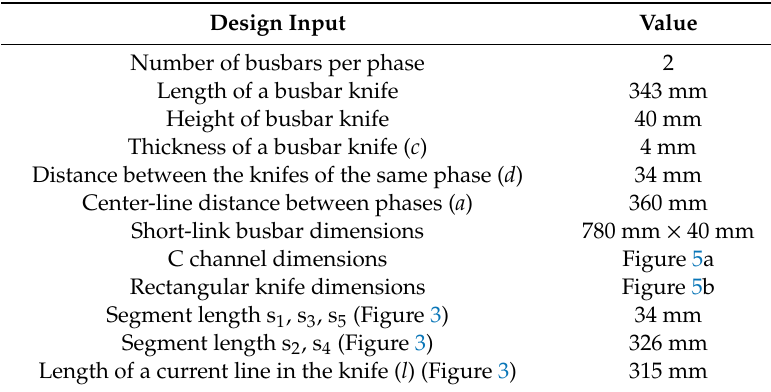
Table 2. Design input